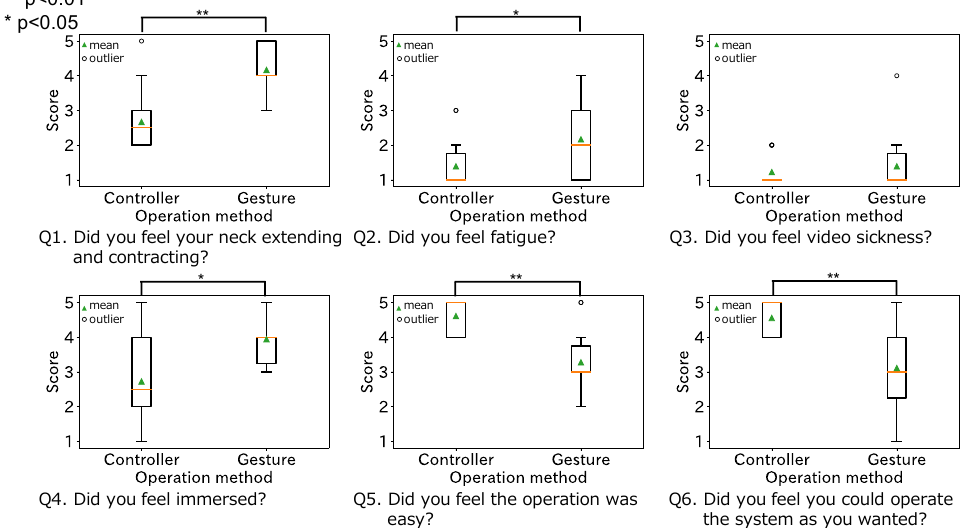
Figure 19. Results of the